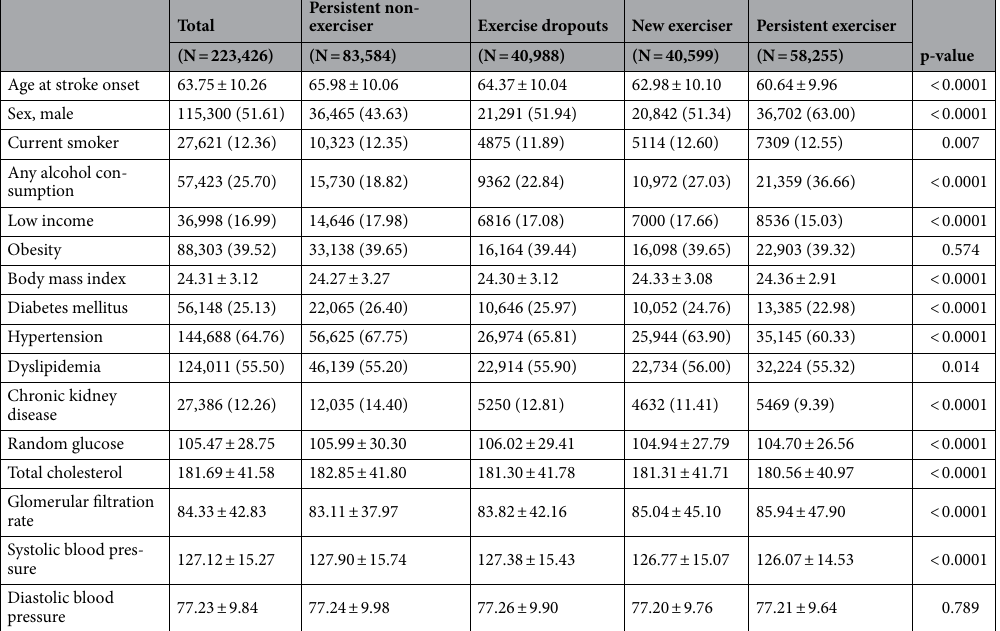
Table 1. Baseline characteristics according to the exercise habit changes in patients with ischemic stroke.